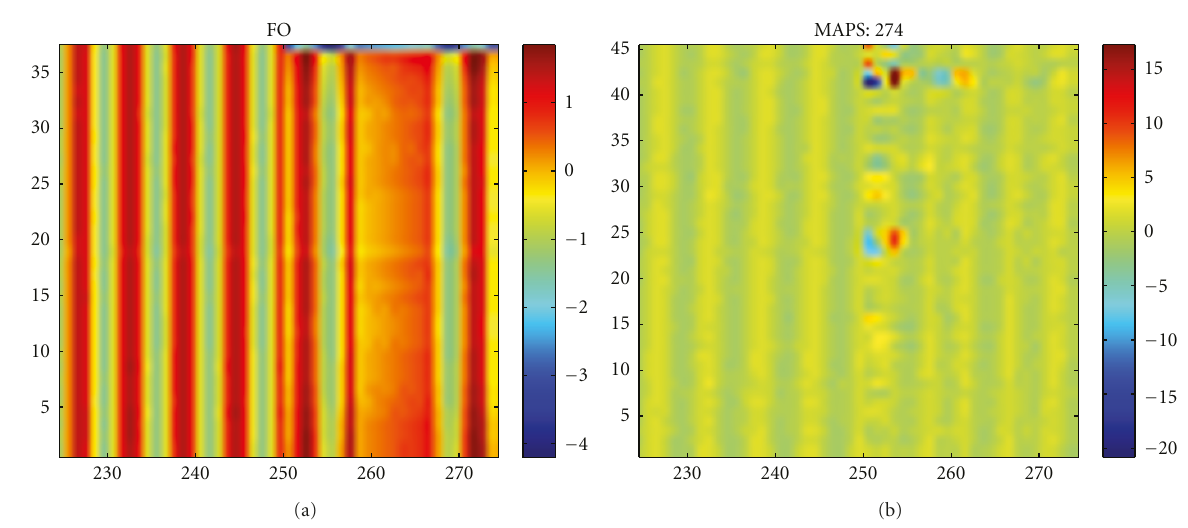
Figure 11: Wire 37